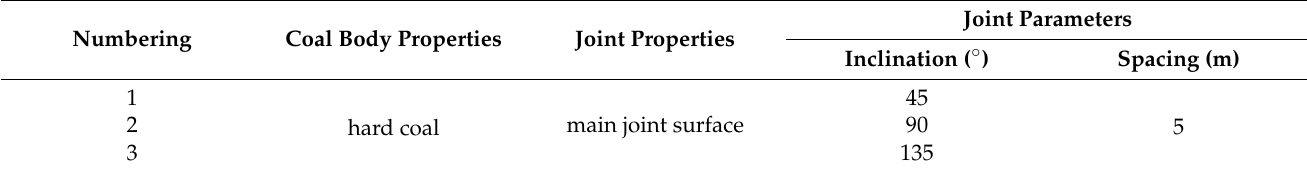
Table 6. Occurrences of joint surfaces with different inclination angles in hard coal